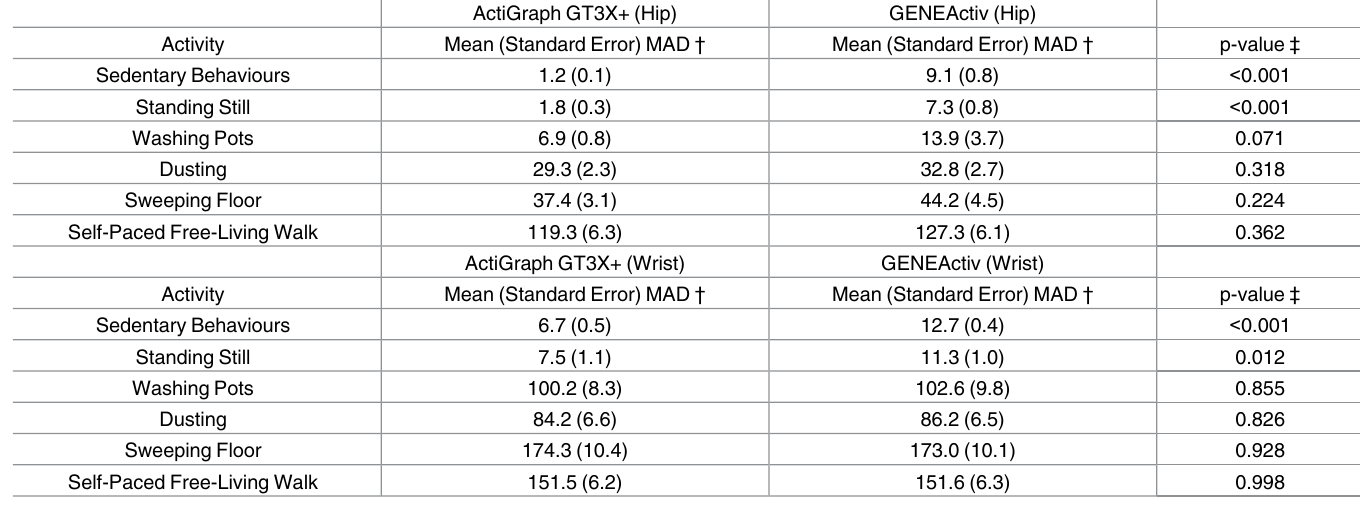
ences in the ENMO metric were only detected during the sedentary behaviours (p = 0.010). For Table 3. Mean (Standard Error) Mean Amplitude Deviation (MAD (measured in milligravity units)) values for each activity stratified by accelerom- eter brand and monitor